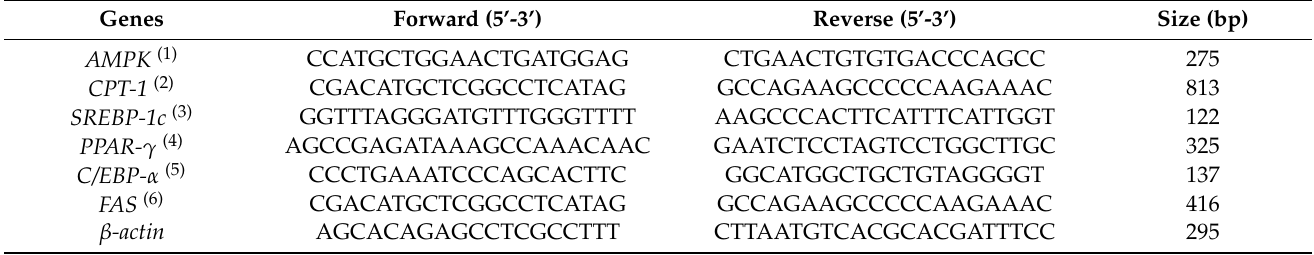
Table 1. Primer sequences used in reverse transcription-polymerase chain reaction (RT-PCR) of major genes related to adipogenesis and